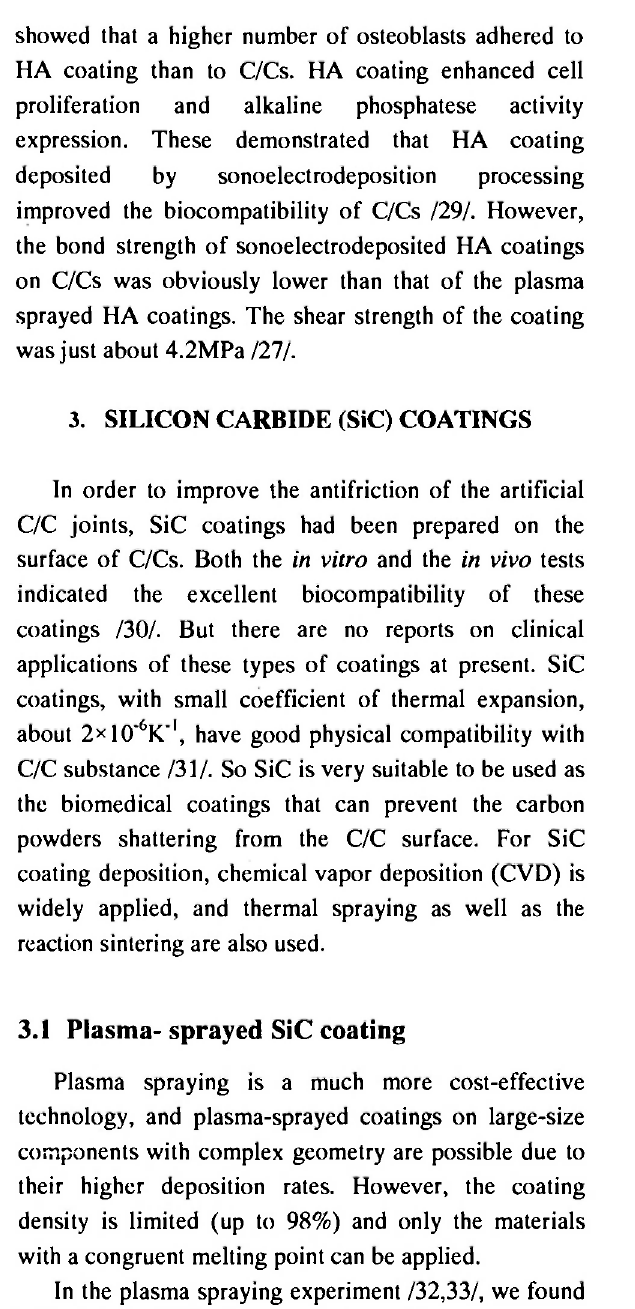
Fig. 2: The process of SiC coatings prepared by